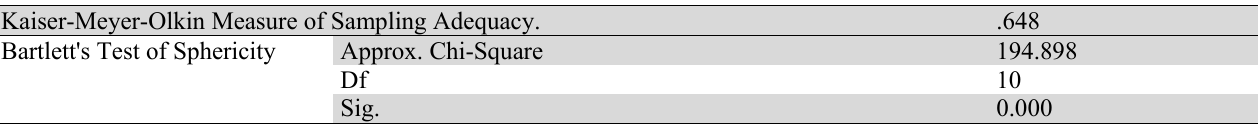
KMO and Bartlett's Test Kaiser-Meyer-Olkin Measure of Sampling